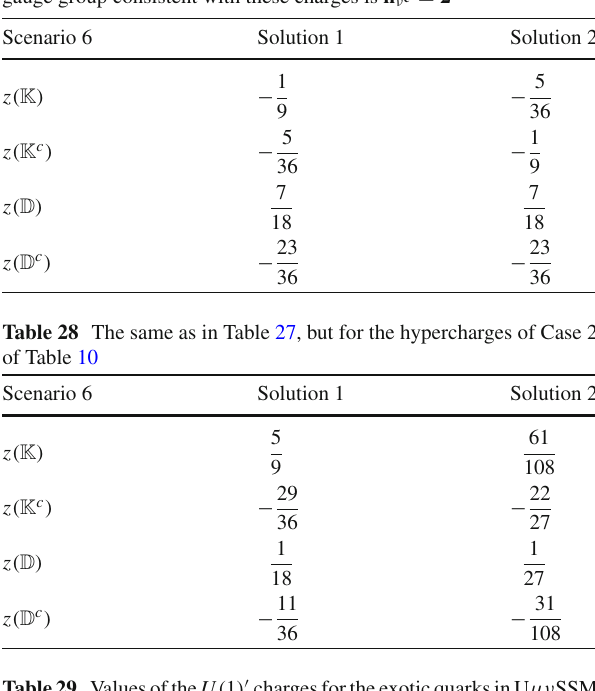
Table27 Valuesofthe U ( 1 ) (cid:2) chargesfortheexoticquarksinU μν SSM models using solution (30) with the hypercharges of Case 1 of Table 10. The U ( 1 ) (cid:2) charges of the rest of the fields are given in Table 2 and